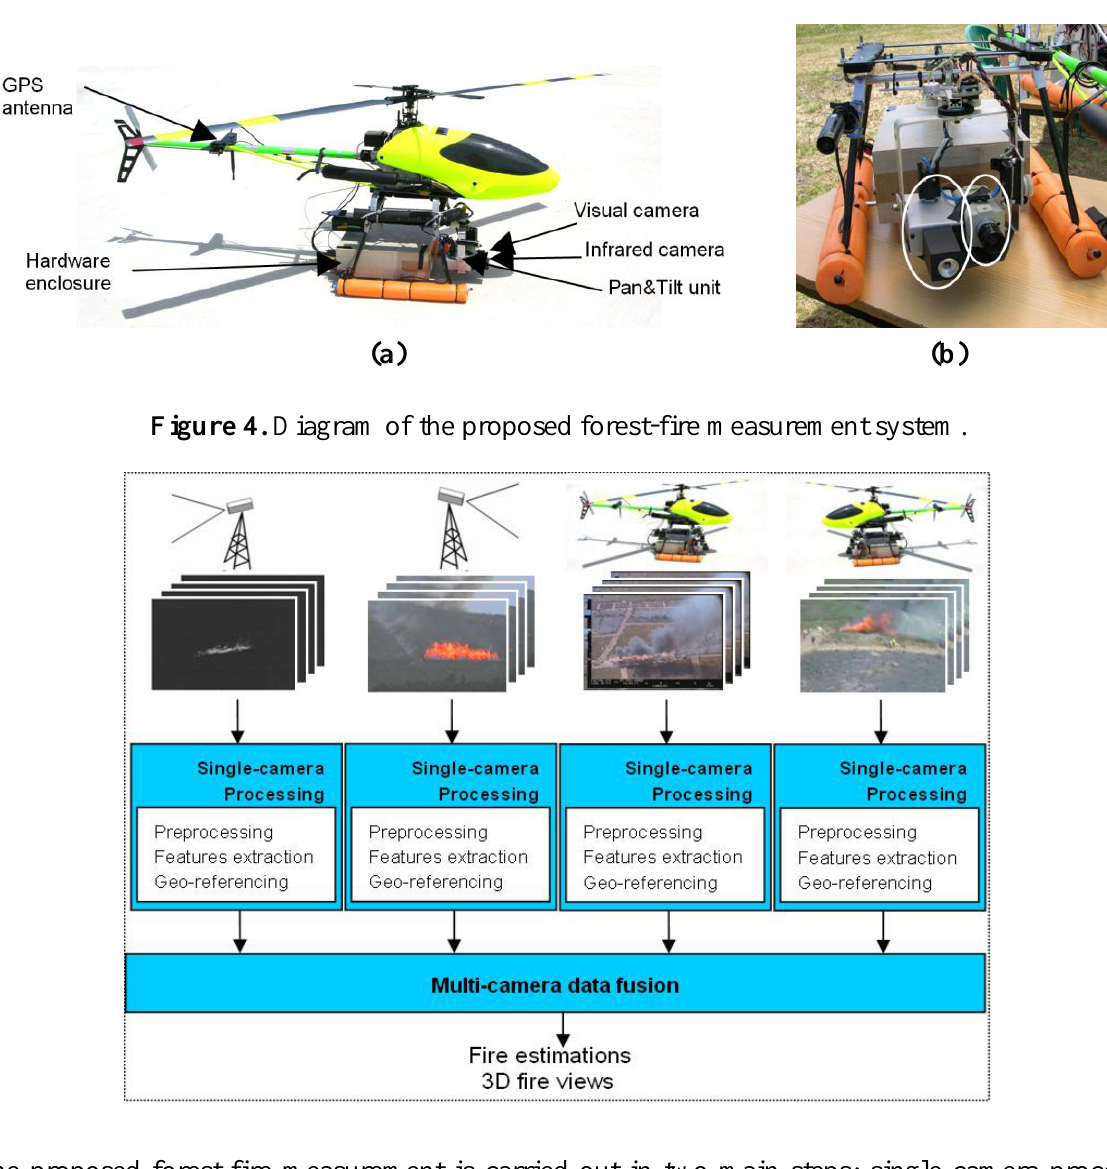
Figure 3. (a) Main sensors and components of one helicopter used in forest-fire measurement. (b) Detailed picture of the pan and tilt device with one Raytheon 2000AS OEM infrared micro-camera and one visual camera.